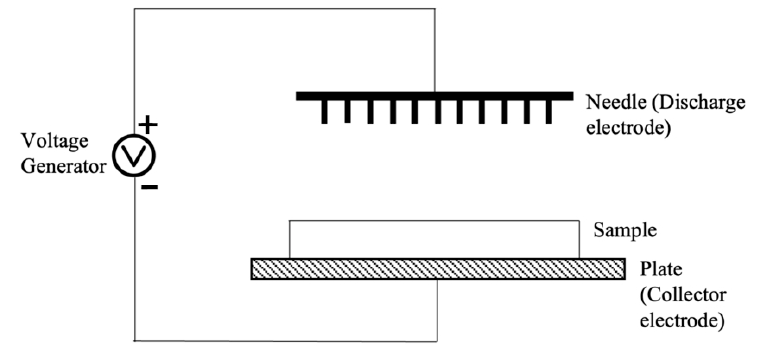
Figure 2. Schematic representation of an electrohydrodynamic drying process (needle-plate system), adapted from Nicholas and Abuzairi [48].